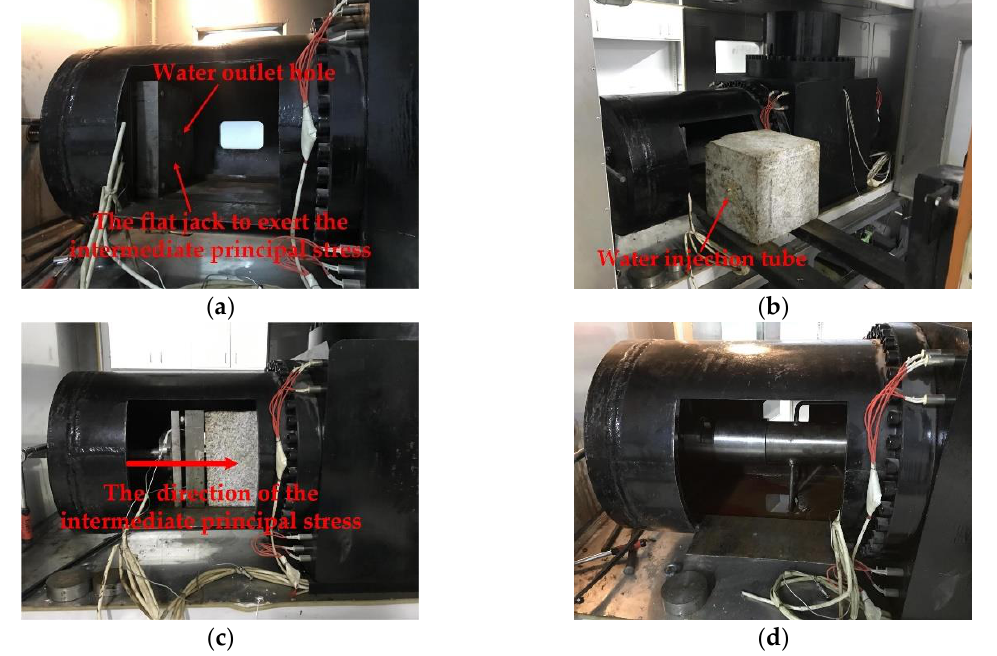
Figure 6. A rock sample is put into the fracturing capsule: ( a ) The rock sample is not put into the capsule; ( b ) A rock sample was putting in to the fracturing capsule; ( c ) The rock sample is push into the fracturing capsule; and ( d ) Three directions confining stresses are